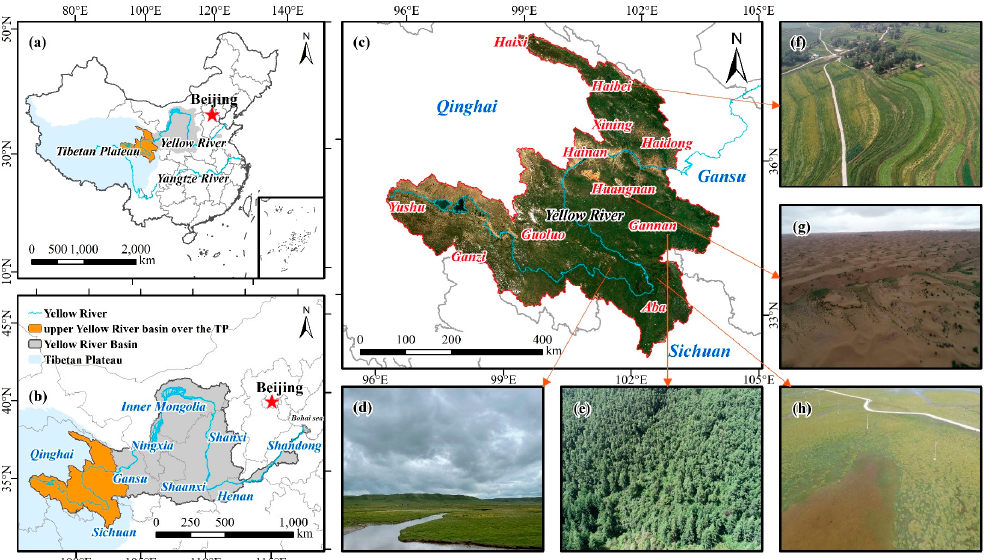
Figure 1. Location of the study area. ( a ) Location of the Yellow River basin in China; ( b ) location of the study area within the Yellow River basin and the Tibetan Plateau; ( c ) examples of true-color images and land use/land cover types for Sentinel-2 from June to August 2020 (( d ): grassland, ( e ): forest, ( f ): agricultural land, ( g ): barren land, ( h ): wetland and water body). Sentinel-2 data for 2020 were obtained online through the GEE platform (https: //code.earthengine.google.com/, accessed on 6 April 2022). Sentinel-2 L2A images